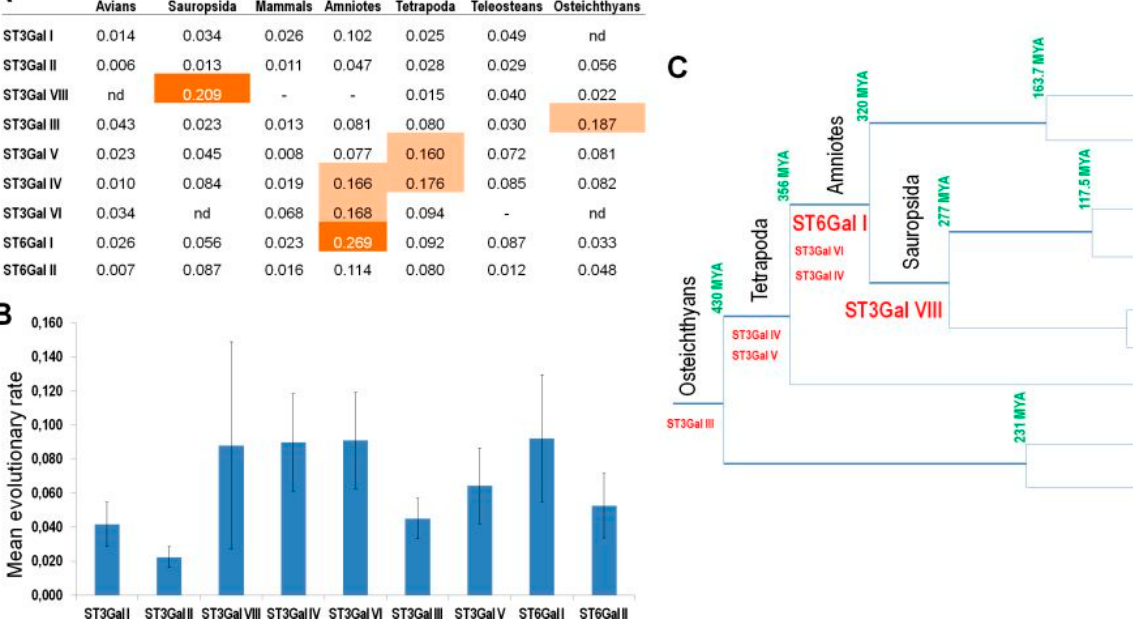
Figure 5. Evolutionary rates of β -galactoside α 2,3/6-sialyltransferase subfamilies in Vertebrates. ( A ) Trees obtained from Minimum Evolution and JTT model implemented in MEGA 6.0 [69] using 91 ST3Gal and 27 ST6Gal sequences allowed calculation of the evolutionary rates of β -galactoside α 2,3/6-sialyltransferase subfamilies for the major divisions in Vertebrates (Data S2). For Amniotes, 2 or 3 sequences were taken, including at least Man and a Marsupial in Mammals, Chicken and Ostrich in Avians, and Caroline Anole and Burmese Python in Lepidosaurians. Orange background denotes the highest values; ( B ) Mean evolutionary rates in the different β -galactoside α 2,3/6-sialyltransferase subfamilies (±standard error). The mean evolutionary rates of ST3Gal and ST6Gal subfamilies were calculated from Teleosteans to Amniotes. The standard errors show variations in the different subfamilies, from the highest in ST3Gal VIII and ST6Gal I, to the lowest in ST3Gal II, ST3Gal I, ST3Gal III and ST6Gal II; ( C ) Highest evolution rates of β -galactoside α 2,3/6-sialyltransferase in vertebrate evolutionary tree. They correspond to the cases where an elevated value is observed in one or two lineages. During the differentiation of Amniotes, we record three subfamilies particularly evolving their catalytic sequences, ST6Gal I and at a lesser extent ST3Gal III and ST3Gal IV. In the lineage of Tetrapods, ST3Gal IV and ST3Gal V present high evolutionary rates. In the ancestors of birds and Lepidosaurians (snakes and lizards, i.e., Sauropsides), there is only one subfamily where numerous changes occur in the catalytic domain, the ST3Gal VIII, as mentioned later on.